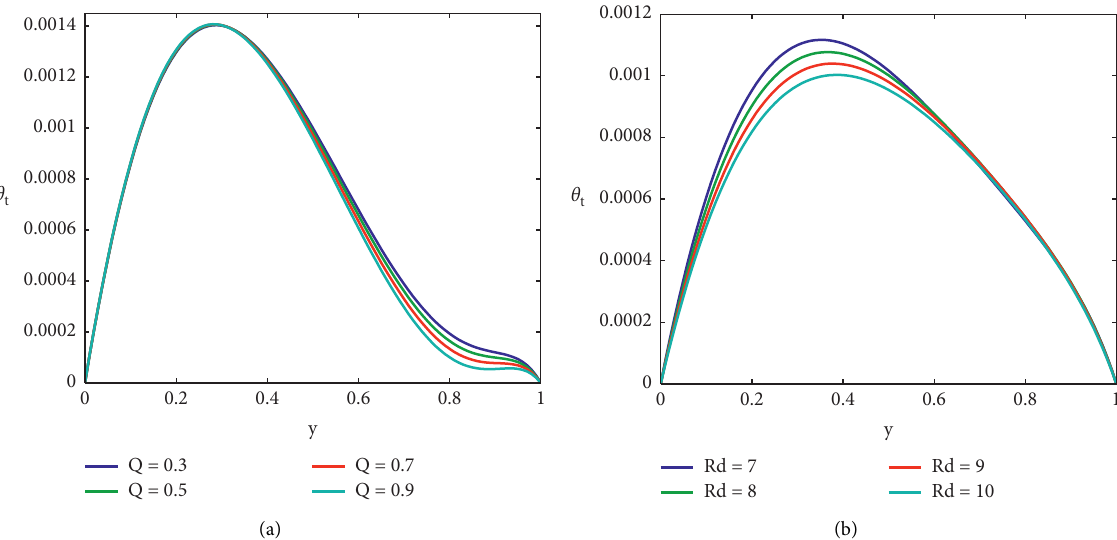
Figure 11: (a) Effect of Q on “unsteady temperature distribution” when Rd � 3. (b) Effect of Rd on “unsteady temperature distribution” for Q � 0.5.